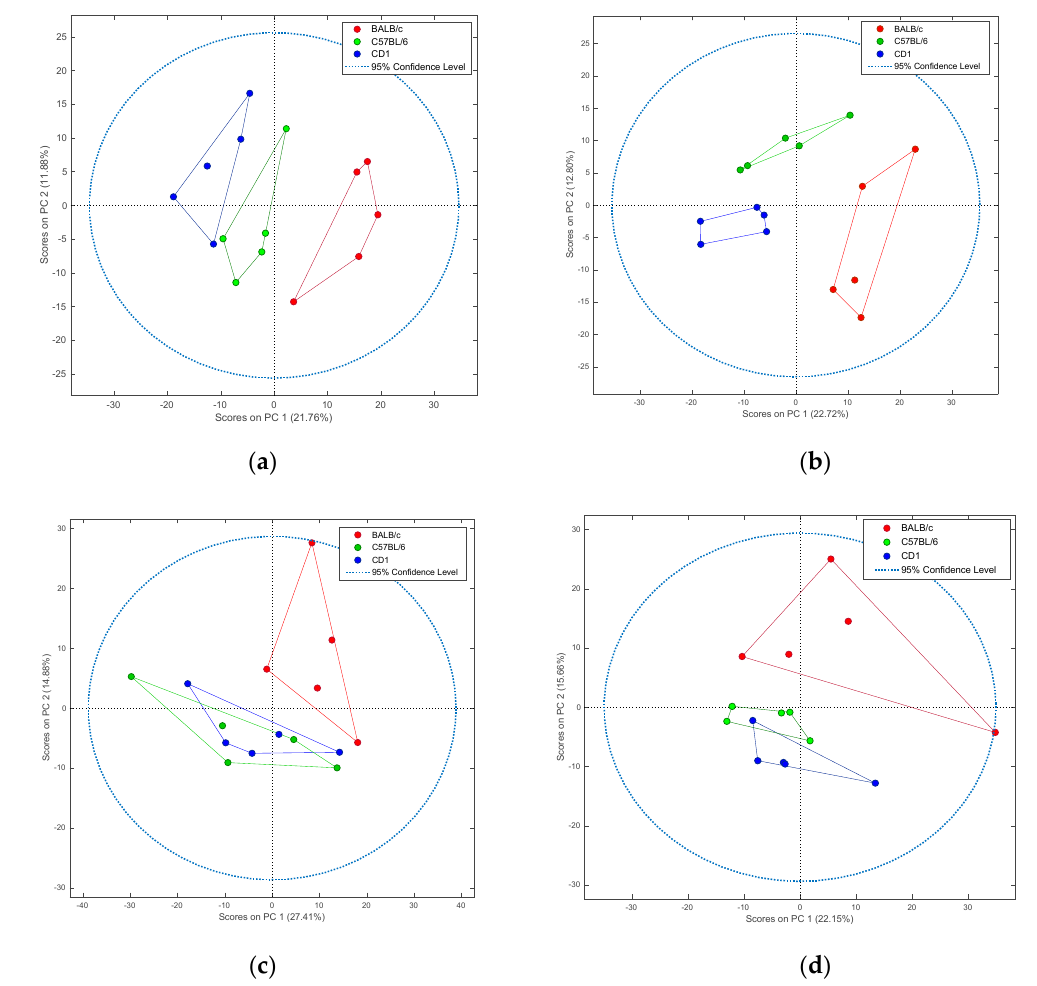
Figure 2. Two-dimensional principal component analysis (PCA) of untargeted metabolomics data of tissues collected from three different mouse strains. Examined strains included: BALB/c (red), C57BL/6 (green), and CD1 (blue). Tissues analyzed included: brain ( a ), liver ( b ), kidney ( c ), and muscle ( d ).